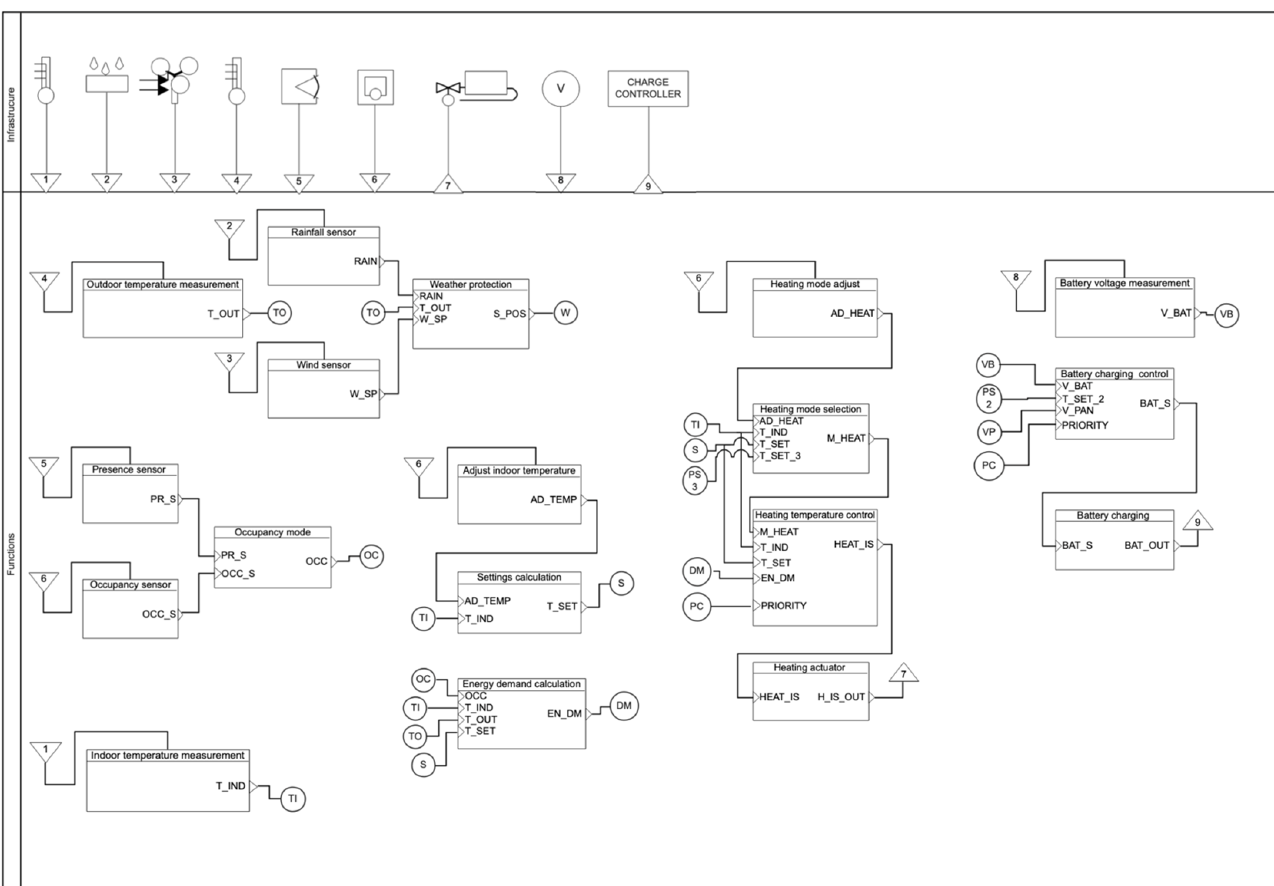
Figure 2. A functional diagram of control and energy management system for small prosumer installation organized according to the EN 15232 standard BACS efficiency class A with additional functions proposed in the paper—part 1.